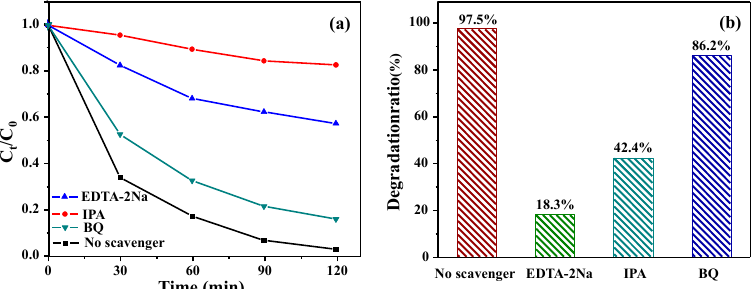
Figure 8. The active species trapping experiments of AAM-35 heterojunction, ( a ) the desulfurization efficiency and ( b ) the thiophene degradation rates of catalyst AAM-35 in the presence of different scavengers.